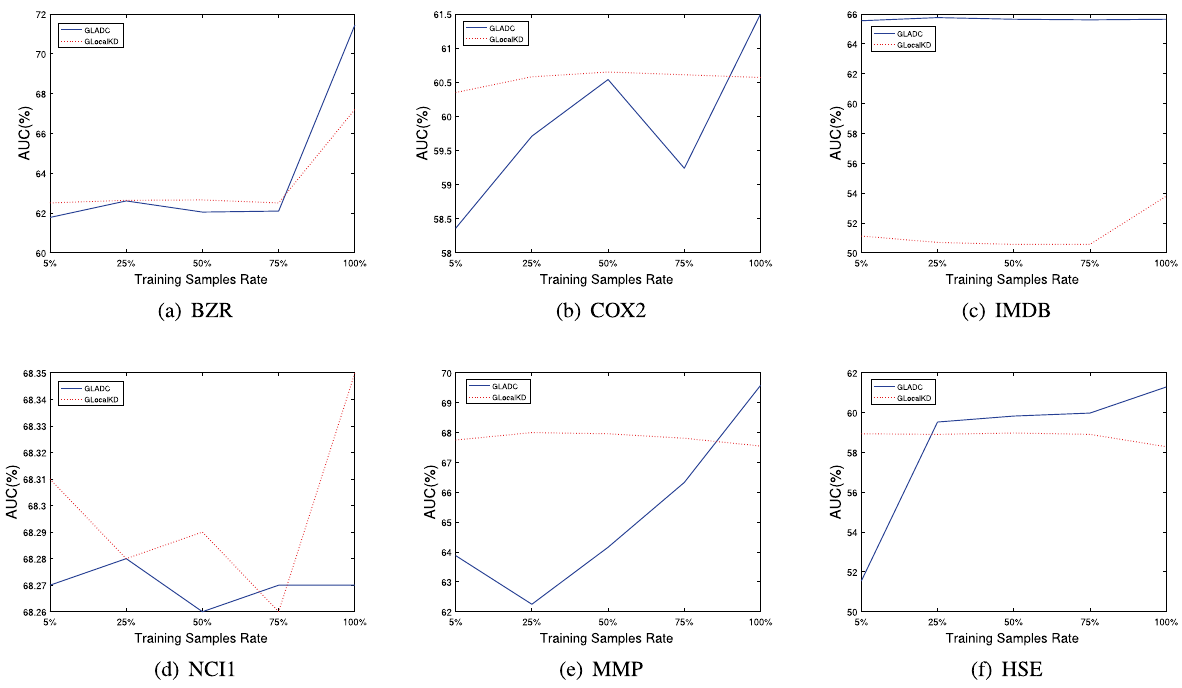
Figure 6. The efficiency analysis of GLADC for different training sample rates on six datasets compared with GLocalKD model.